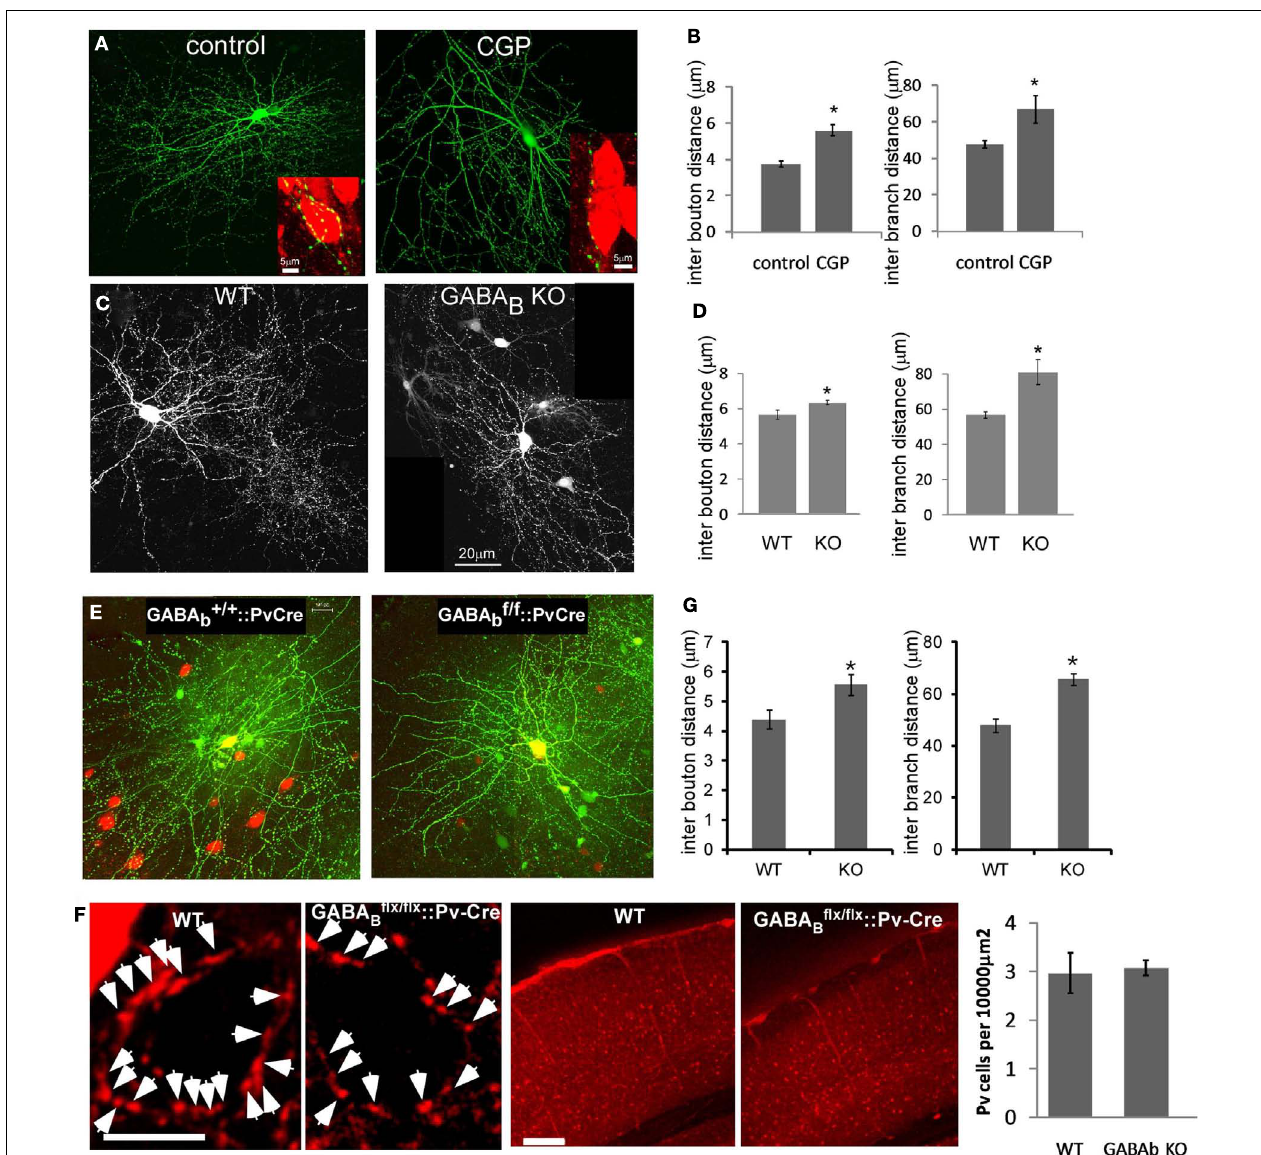
prepared at P40 and RFP labeled PV neurons were patch clamped and filled with biocytin. Biocytin loaded PV neurons were fixed and immunostained indicated genotypes were sacrificed and perfused at P40. Coronal sections were immunostained for PV in red. Layer 2/3 of visual cortex was imaged. Arrows indicate the perisomatic PV cell axon terminals.The middle panel shows the lower magnification view of visual cortex stained for PV in red. The number of PV positive neurons was quantified and showed no difference betweenWT and GABA B R KO samples ( n = 15 regions from three animals). (G) The bouton density and axon branching of neurons in (E) were fully reconstructed and analyzed (nineWT neurons, eight KO neurons; * P <